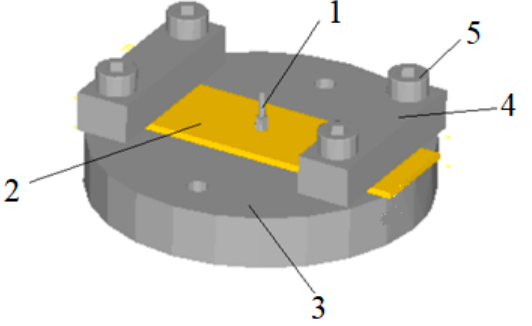
Figure 5. The simulation model of micro gear blanking processing. 1. Punch; 2. Workpiece; 3. Die; 4. Press plate; 5. Screw.